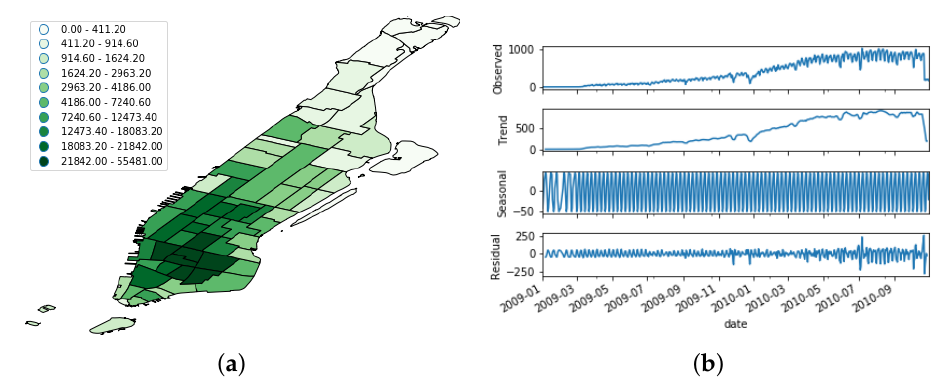
Figure 6. Distribution of the Foursquare dataset. ( a ) Spatial distribution; ( b ) Temporal evolution. The uppermost figure shows the raw time series, whereas the other bottom ones depict its decomposition in trend, seasonal, and noise